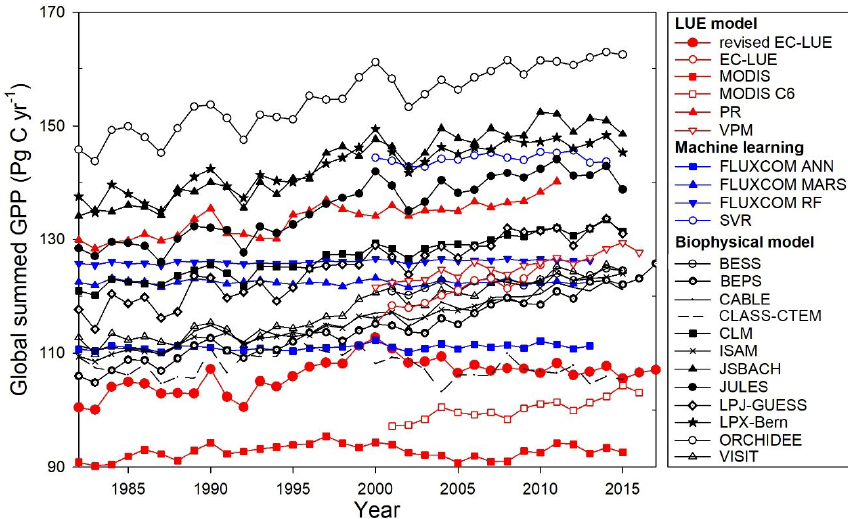
Figure 10. Comparisons of annual global summed GPP estimates from various models. The datasets or model algorithms were obtained from EC-LUE (Cai et al., 2014), MODIS (Smith et al., 2016), MOD17 C6 (Running et al., 2004), PR (Keenan et al., 2016), VPM (Zhang et al., 2017), FLUXCOM (Jung et al., 2017), SVR (Kondo et al., 2015), BESS (Jiang and Ryu, 2016), BEPS (Ju et al., 2006; Liu et al., 2018), and models in TRENDY (CABLE, CLASS-CTEM, CLM, ISAM, JSBACH, JULES, LPJ-GUESS, LPX-Bern, ORCHIDEE, and VISIT).